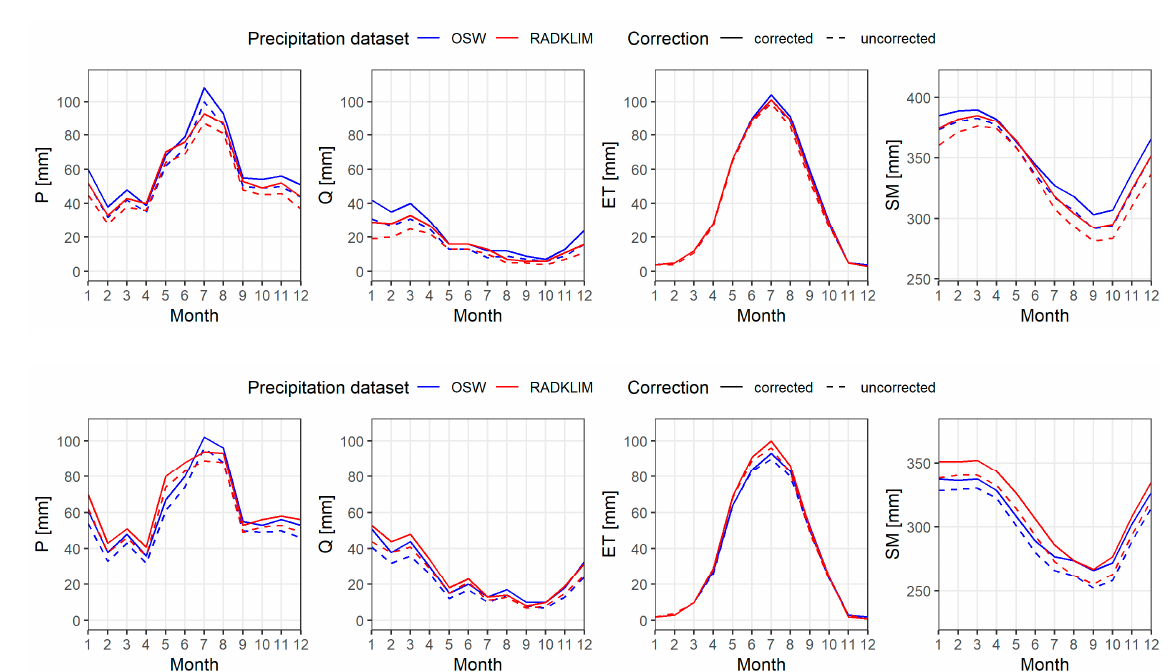
Figure 9. Monthly average of water balance components (precipitation (P), discharge (Q), evapotranspiration (ET), and soil moisture content (SM)), exemplary for Holtendorf catchment (above) and Niederoderwitz catchment (below) in the period 2001–2017.